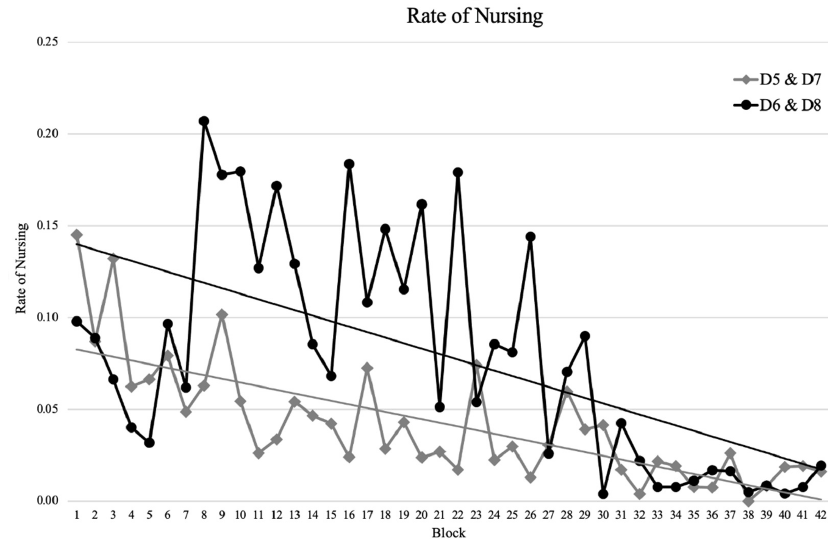
Figure 3. Rates of nursing over the 10-month observation period. On average, D7 and D5 spent 55.11% of their time together, and D8 and D6 spent 40.74% of their time swimming as a mother–calf dyad. Figure 4 suggested the percentage of time spent swimming as a dyad remained relatively stable over a ten-month period for both mother–calf dyads. The rates of nursing and swimming as a dyad were not statisti- cally compared because D6 was one year older than D5.